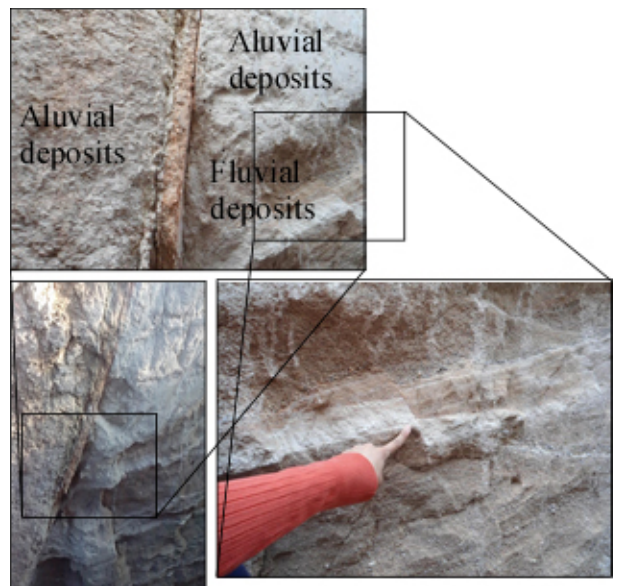
Figure 5. Trench excavated to physically observe a fault at depth. This is point 4 in Fig. 2. Observations indicate that hanging wall seems to be on the west of the fault, not to the east, which is toward the center of the